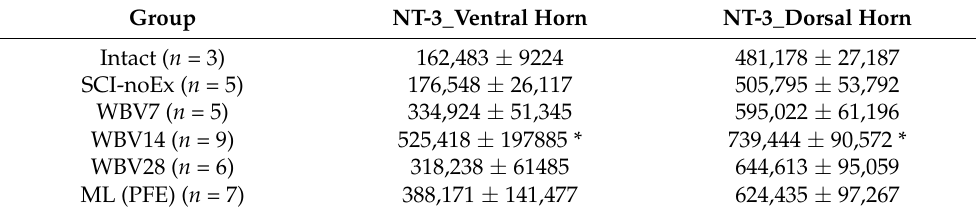
Table 4. NT-3 expression, as defined by pixel number per mm 2 of tissue area (PN/mm 2 ) in the ventral horns and dorsal horns of the lumbar-spinal-cord L2 segments of intact and injured, treated, and non-treated rats at 12 weeks after SCI. The relative NT-3 expression values (PN/mm 2 ) were calculated by rectifying the absolute NT-3 expression values or pixel numbers for the specific AOI used in the ventral horn (AOI ≈ 0.5177 mm 2 ) and dorsal horn (AOI ≈ 0.2223 mm 2 ) in order to allow direct comparison between the ventral horn and dorsal horn. Groups’ mean values ± SD are